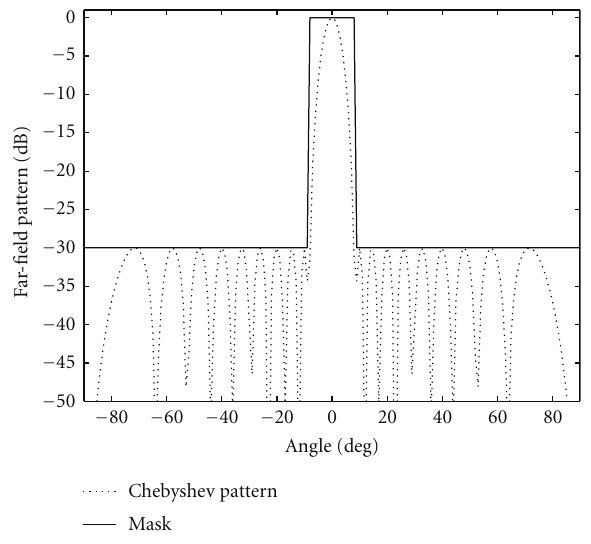
Figure 1: Chebyshev array pattern and the mask used for corre- sponding damaged